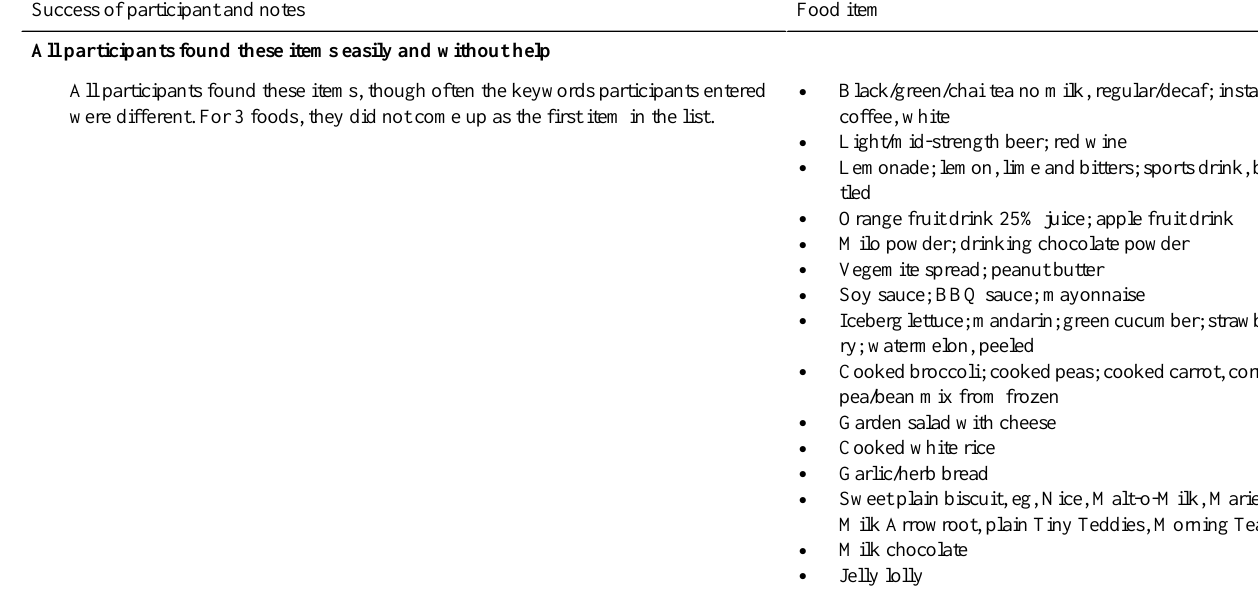
Table 1. Issues raised in Phases 1 and 2 of usability testing.